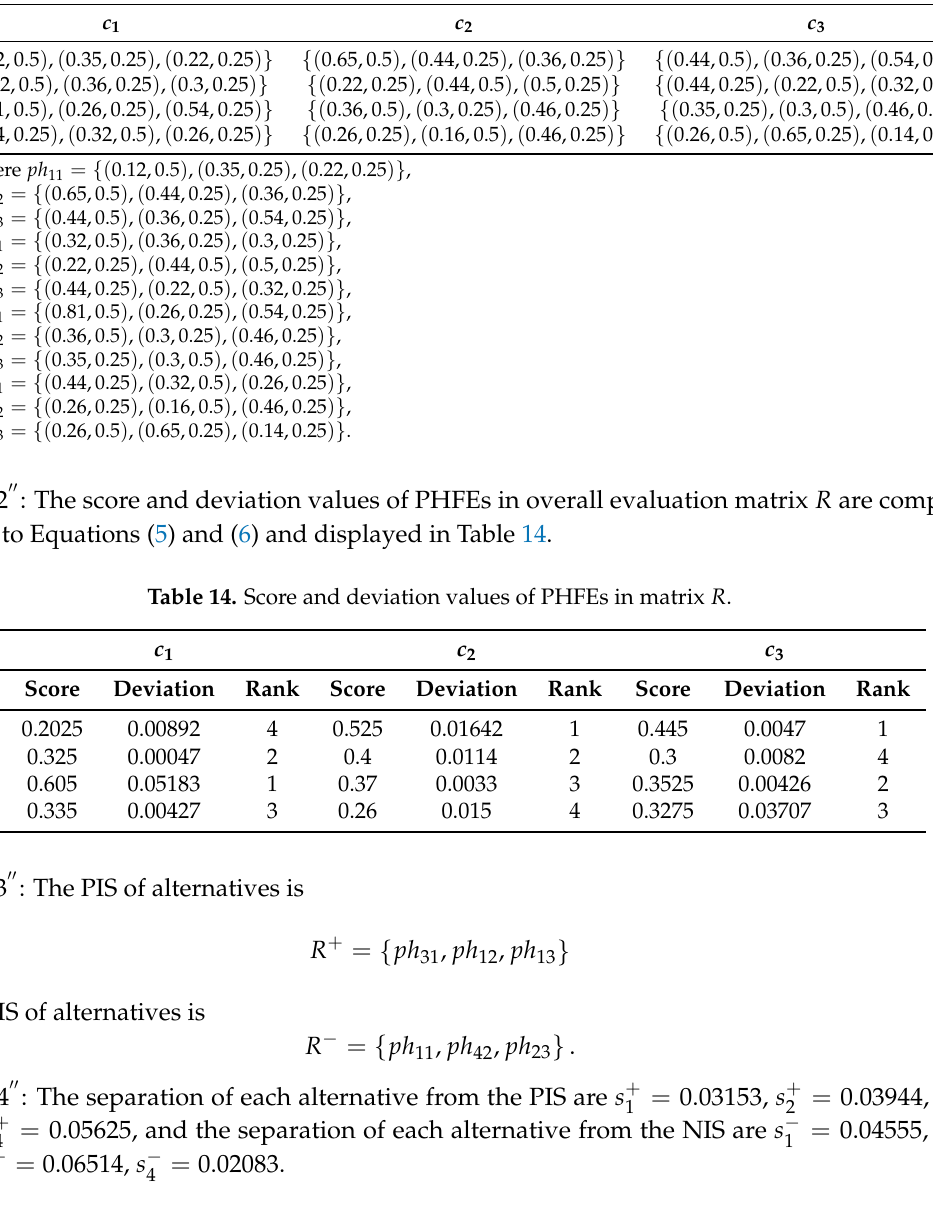
Table 13. The overall evaluation matrix R .